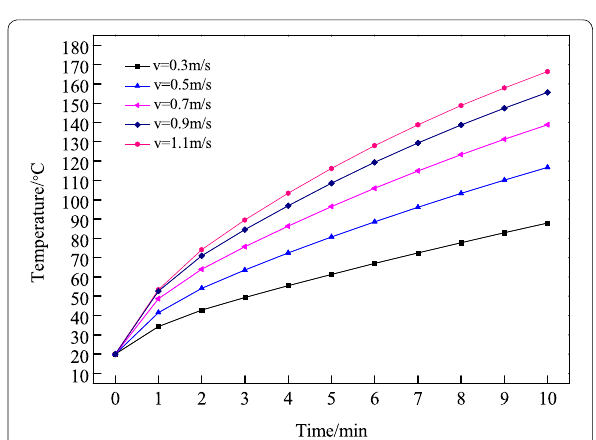
Figure 9 Simulation temperature curve of point c under different velocities